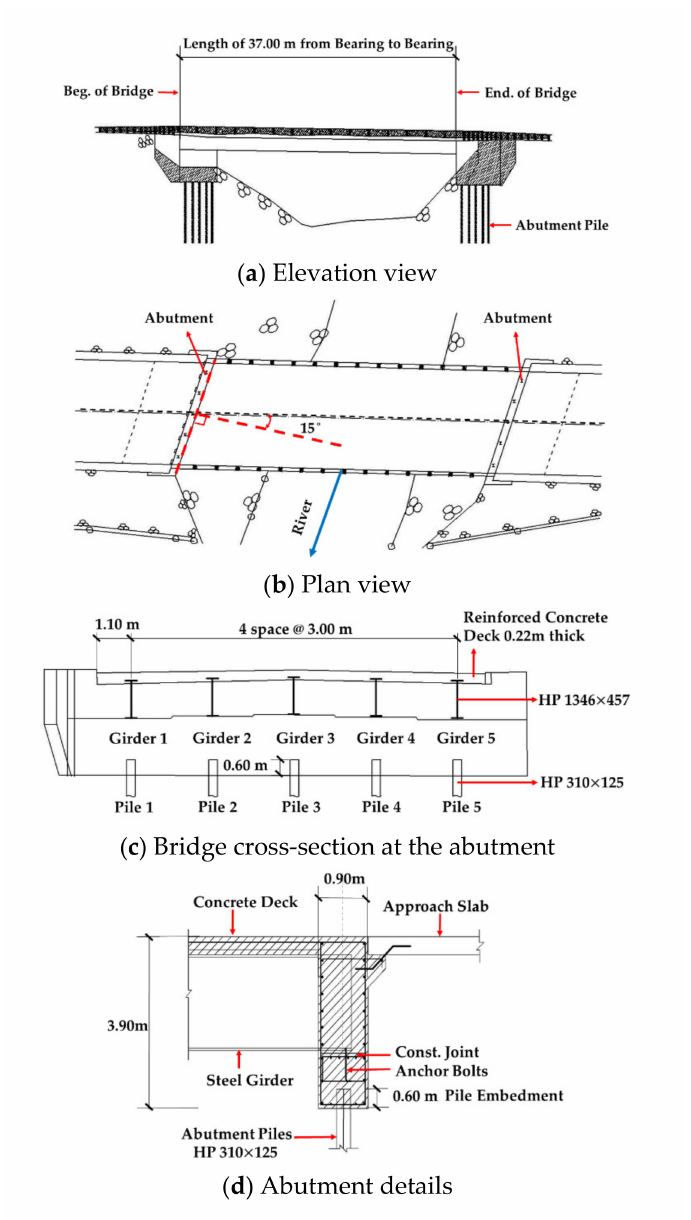
Figure 1. A skewed integral abutment